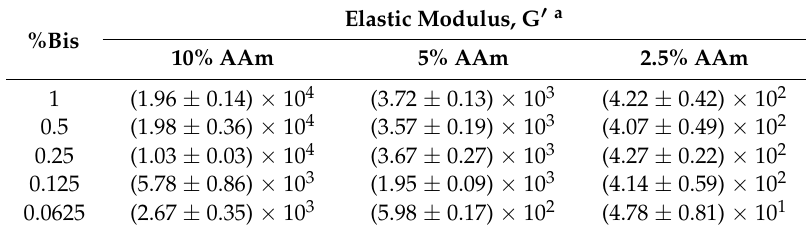
Table 1. Elastic modulus, G (cid:48) , for neat hydrogels for various monomer and crosslinker ratios.